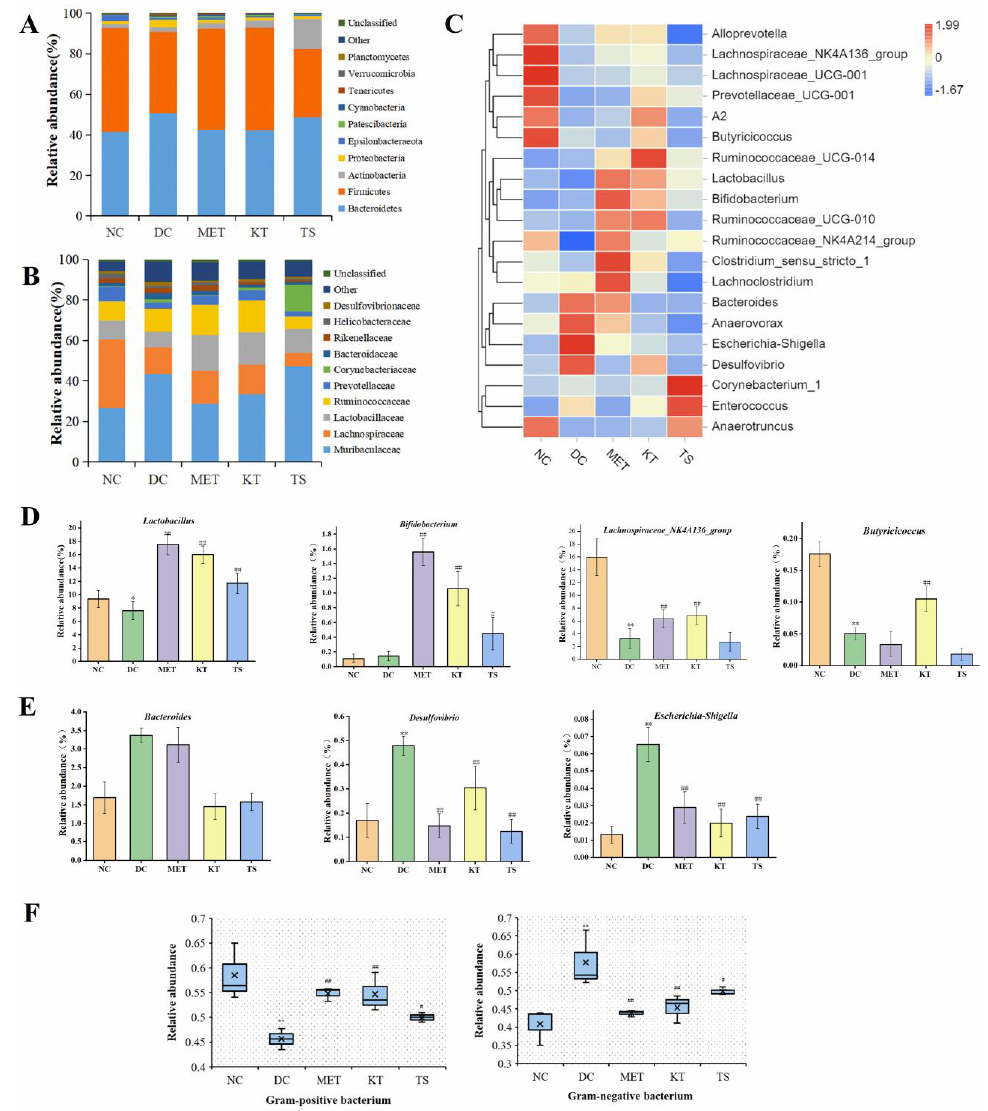
Figure 4. Effect of kombucha on the gut microbiota composition in T2DM mice. ( A ) Relative abundance at phylum level; ( B ) Relative abundance at family level; ( C ) Relative abundance at genus levels; ( D ) Relative abundance of SCFAs − producing bacteria ( Lactobacillus, Bifidobacterium, Butyricicoccus, Lachnospiraceae_NK4A136_group ); ( E ) Relative abundance of proinflammatory bacteria ( Desulfovibrio, Escherichia−Shigella, and Bacteroidetes ); ( F ) Relative abundance of gram − positive bacteria and gram − negative bacteria. * p < 0.05, ** p < 0.01 vs. Normal; # p < 0.05, ## p < 0.01 vs. Model.